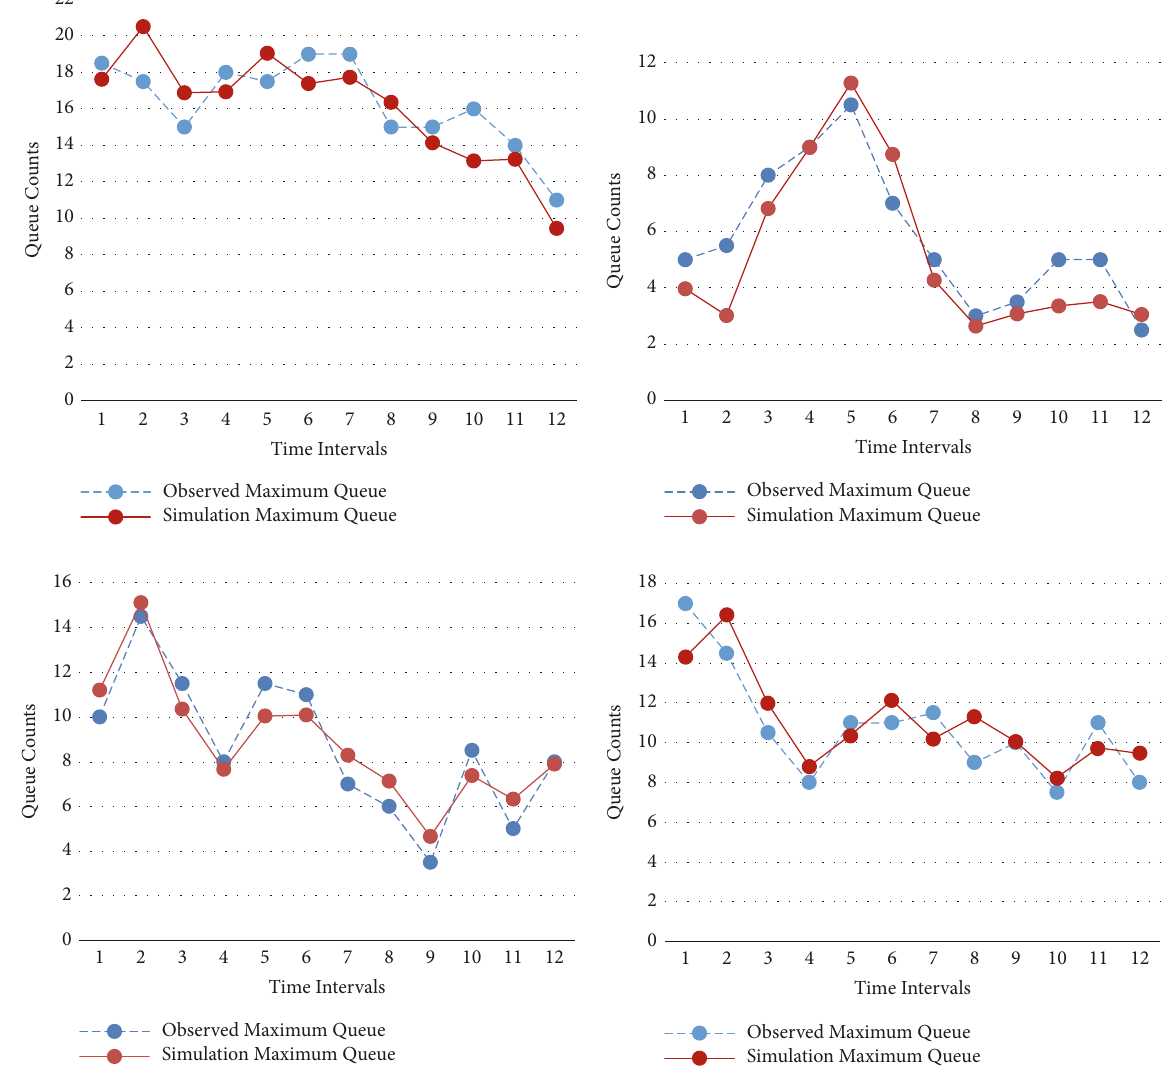
Figure 3: Calibration of VISSIM model (EBL, WBL, SBL, and NBL